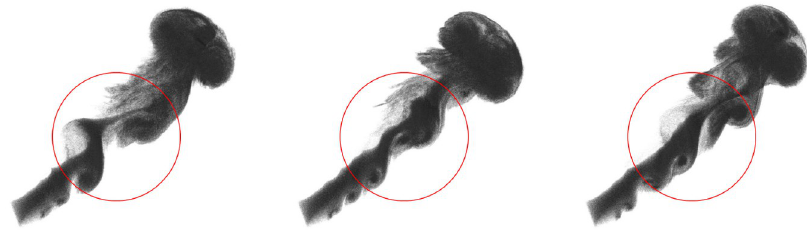
Fig 4. Rising smoke with three different values of V . Left: V = 64 υ 3 ; middle: V = 8 υ 3 ; right: V = υ 3 . Here, υ is 6.28 � 10 − 3 . And the difference of the vortices are marked by the red